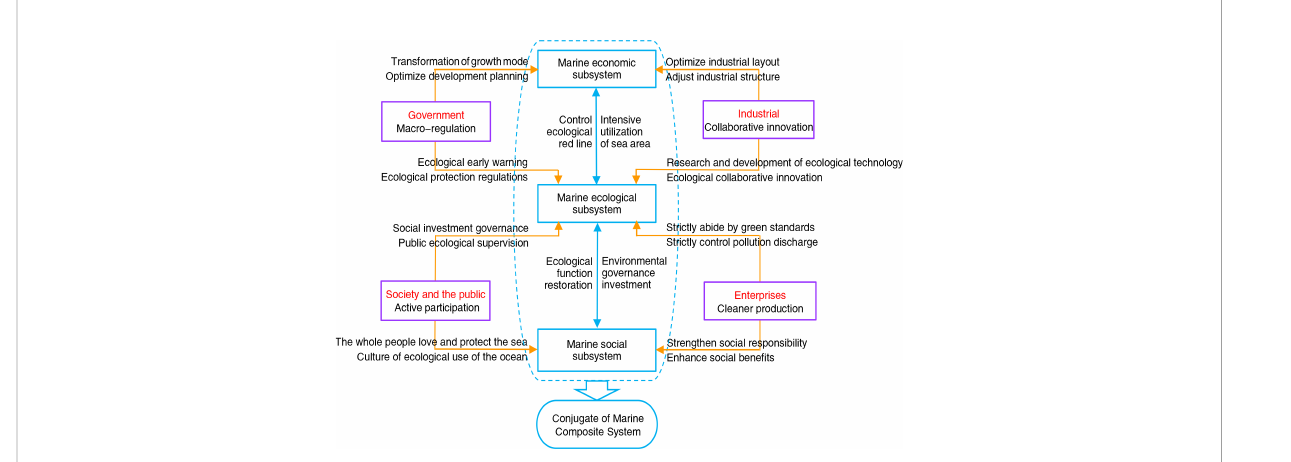
FIGURE 9 Policy framework for conjugate regulation of marine composite